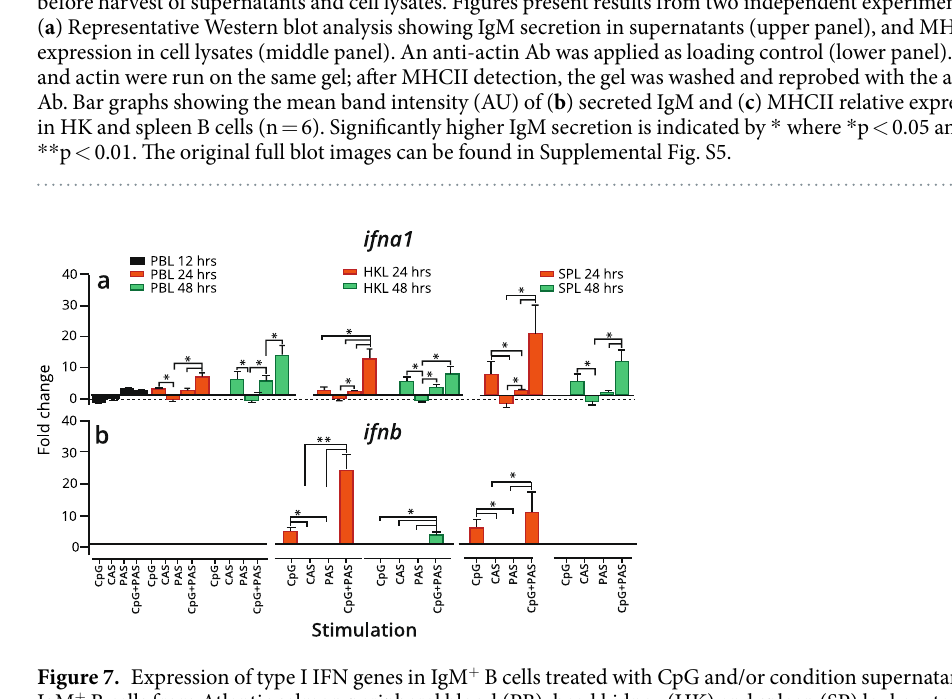
Figure 7. Expression of type I IFN genes in IgM + B cells treated with CpG and/or condition supernatants. IgM + B cells from Atlantic salmon peripheral blood (PB), head kidney (HK) and spleen (SP) leukocytes were MACS sorted, stimulated in vitro or left untreated and analyzed by RT-qPCR for expression of ( a ) ifna1 and ( b ) ifnb genes. Gene expression data at each time point were normalized against the endogenous control EF1aB and fold changes were calculated using unstimulated cells at the same time point 74 . Data represent mean ± s.e.m from at least three individuals (n = 3 to 6). The line intersecting the y-axis at 1 represents the unstimulated control that the fold change of the treatments are in relation to. Significant fold changes, p < 0.05 or p < 0.01, are indicated by * or ** , respectively. CAS; Control adherent cell supernatant, PAS; Pulse adherent cell